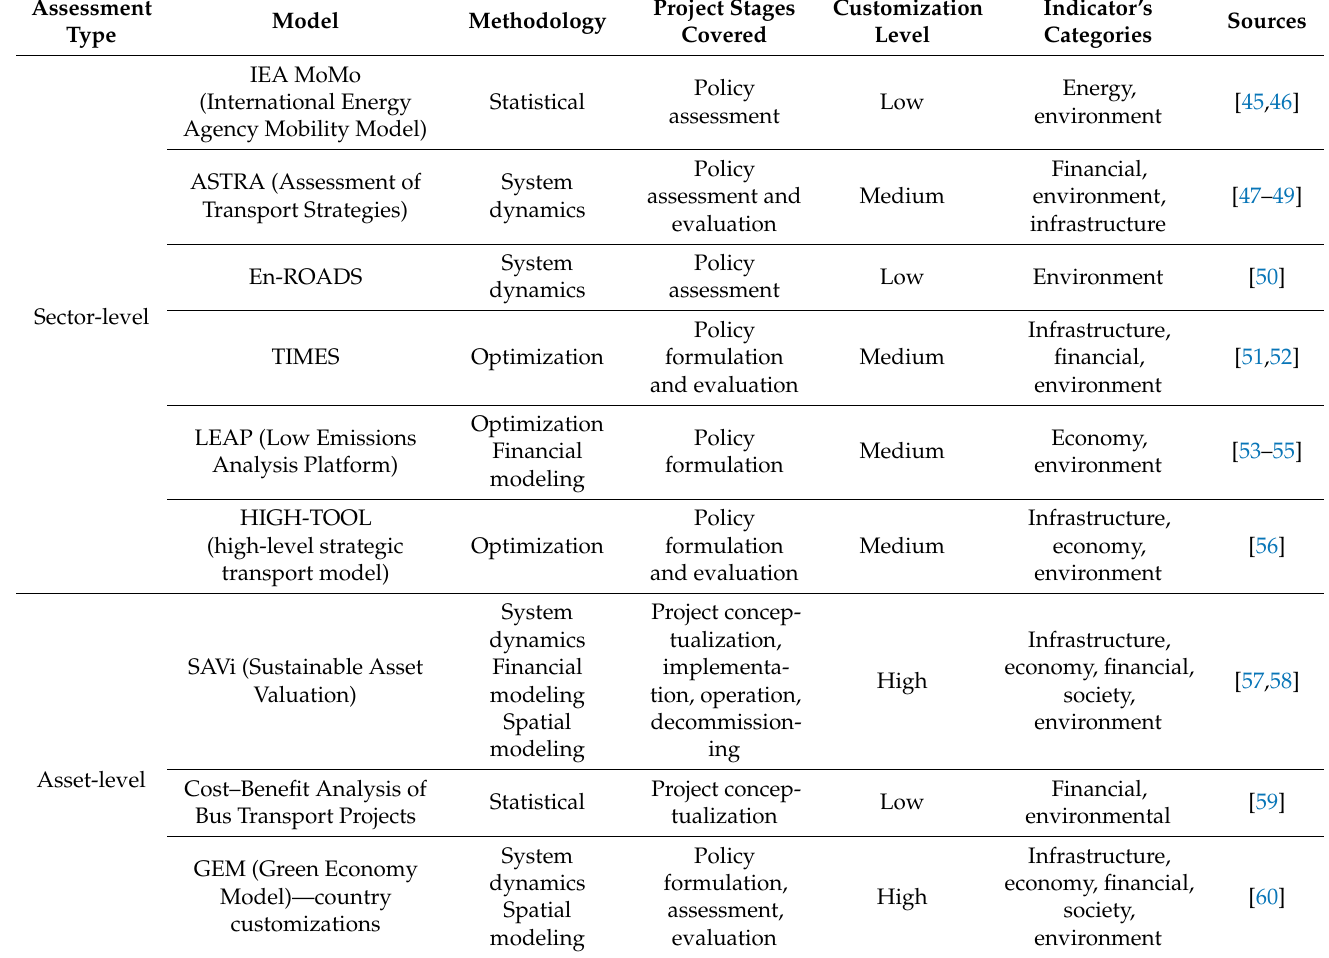
Table 1. Summary of the models to assess sustainable